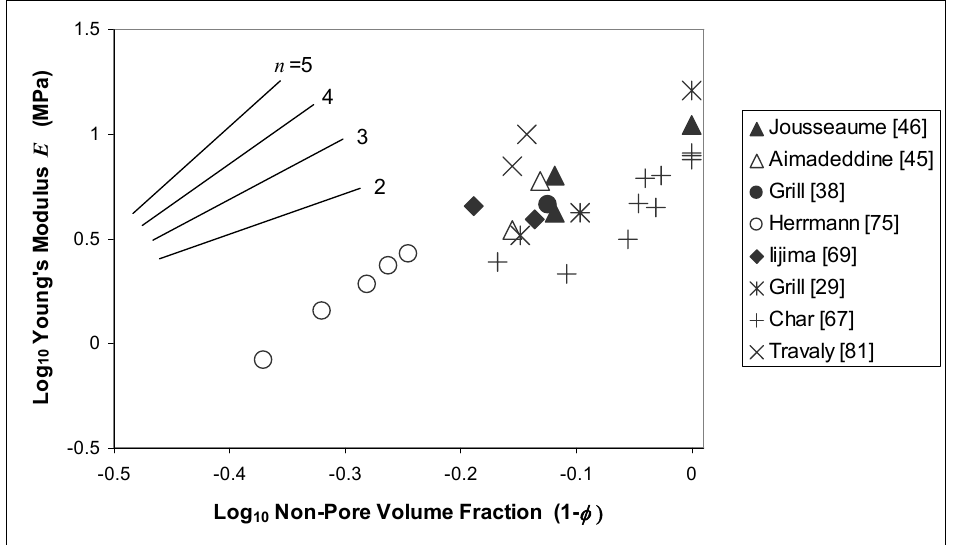
Figure 4. Young’s modulus E plotted against non-pore volume fraction (1- φ ) for several PECVD and spin-on dielectric materials. The lines represent the expected slope for different values of exponent n in equation